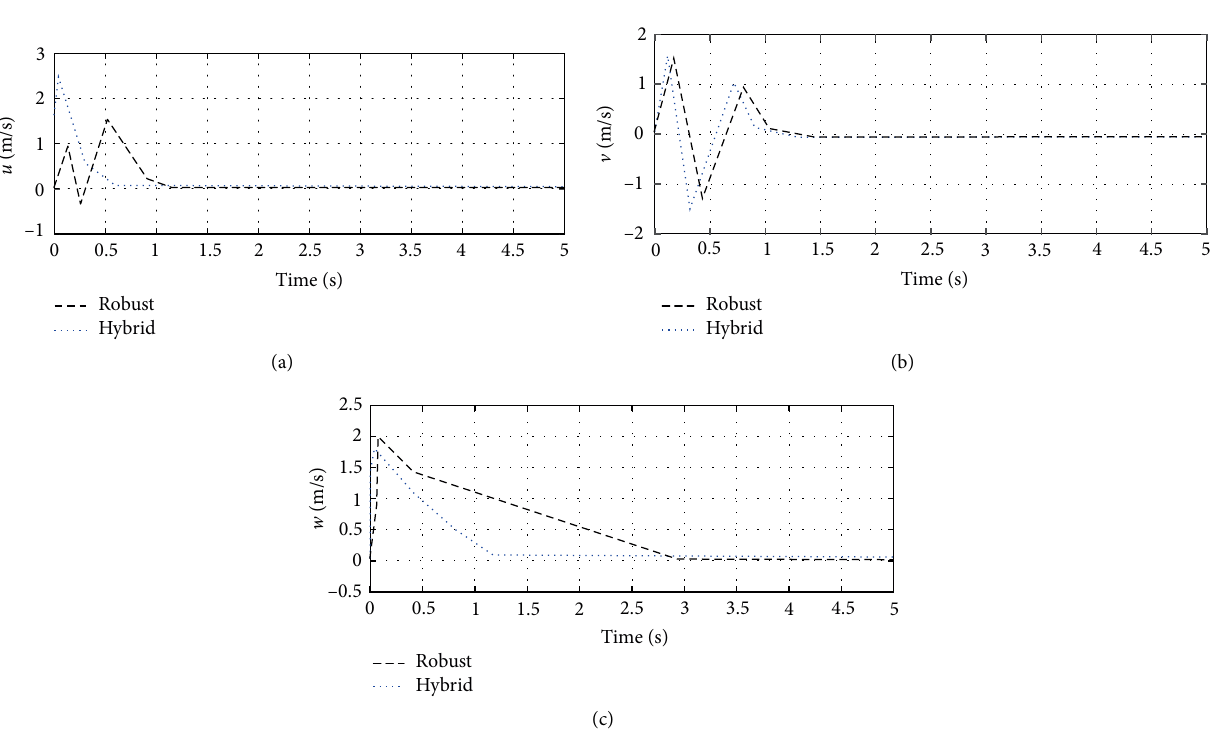
Figure 6: (a) The translational velocity u (m/s). (b) The translational velocity v (m/s). (c) The translational velocity w (m/s).